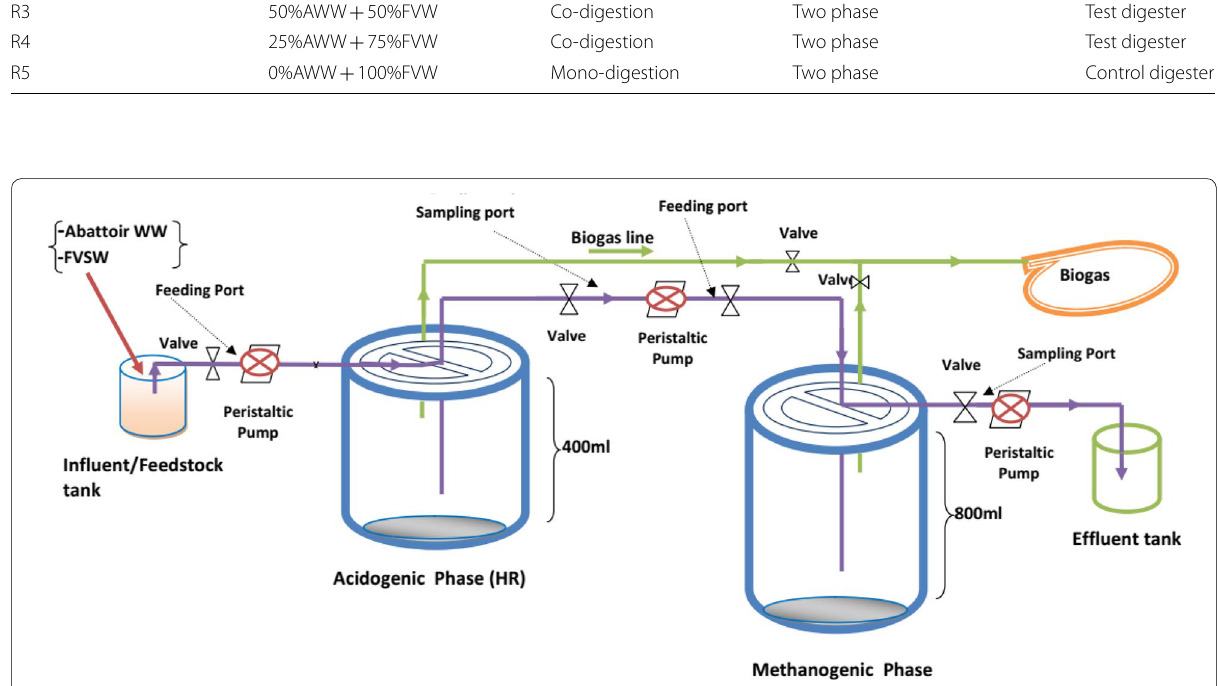
Table 3 Proportion of mixture of the substrates (AWW and FVW) Representation Proportion of substrates of the mixed ratio (mixing ratio)